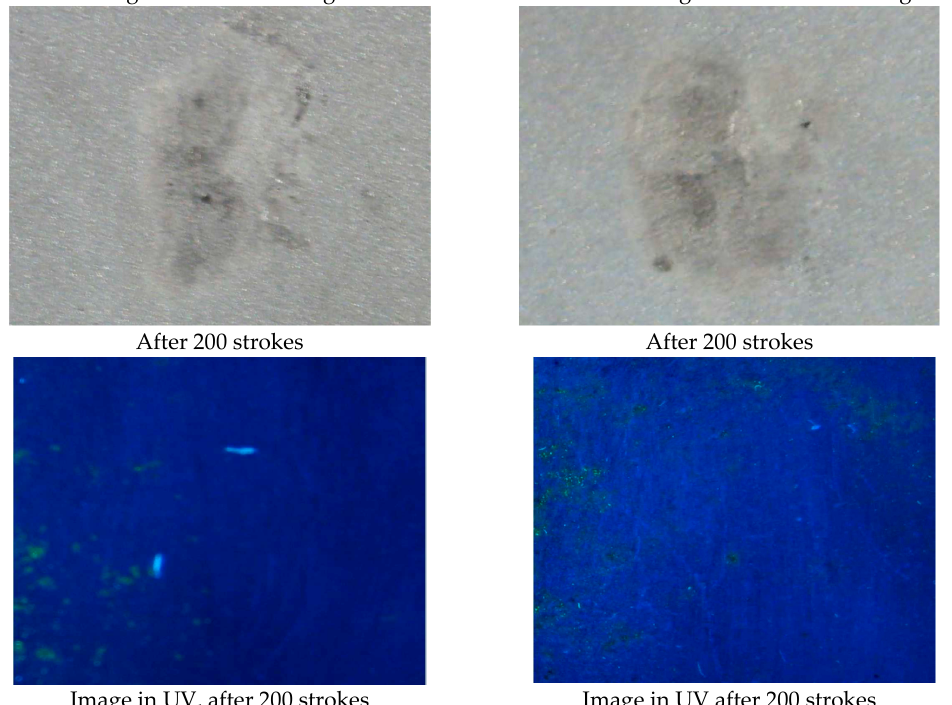
Figure 8. View of aluminum arc-sprayed coatings on Armox 500 T steel after impact resistance tests (impact energy 200 J).